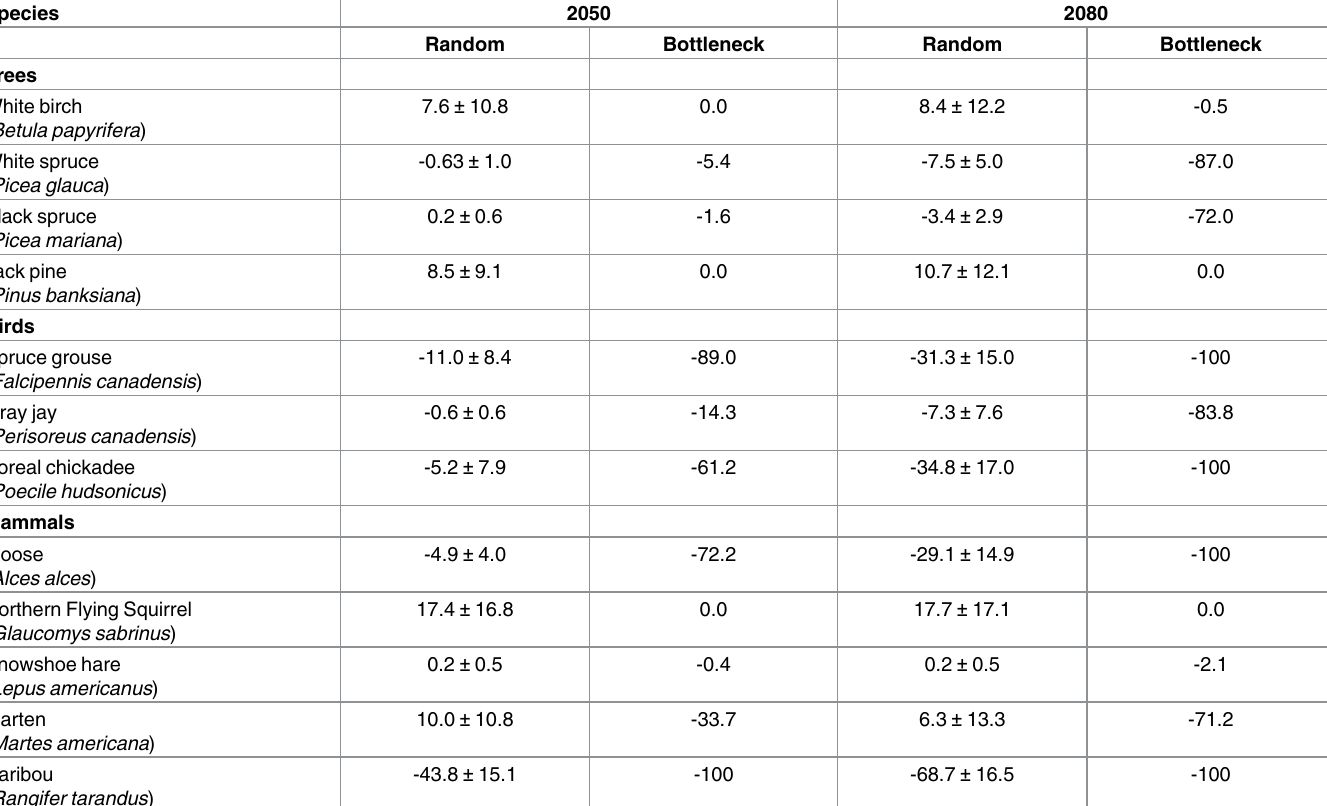
Table 4. Change in climate suitability (%) for boreal forest species in randomly-selected regions of the boreal forest and the Ontario-Que´bec bot- tleneck region. Species Random Bottleneck Random